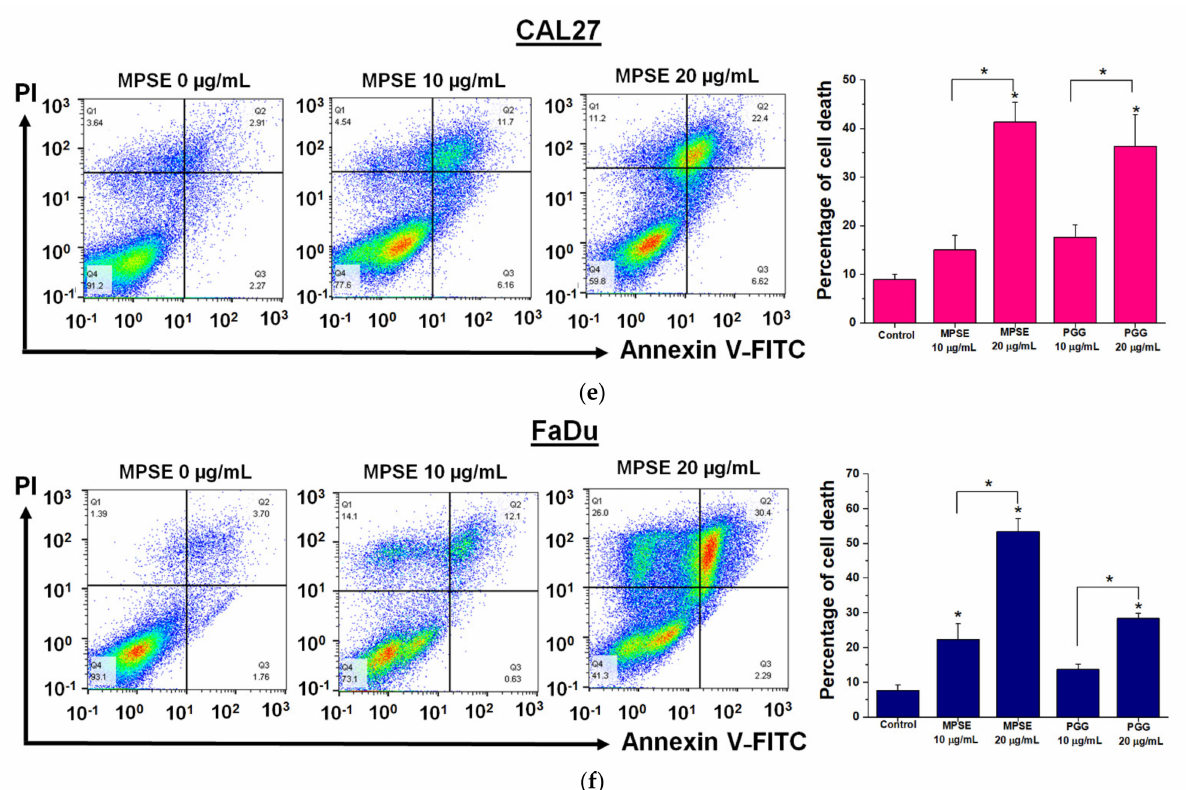
Figure 2. MPSE or PGG suppressed cell proliferation and induced apoptotic cell death in HNSCC cell lines. ( a ) Effect of MPSE or PGG on cell viability of CAL27 cells assessed via MTT assay. ( b ) Effect of MPSE and PGG on cell viability of FaDu cells assessed via MTT assay. ( c , d ) The colony-formation ability of HNSCC cell lines treated with different concentrations of MPSE for 48 h, then seeded (1 × 10 4 ) in triplicate in a 6-well plate. After two weeks of incubation, formed colonies were counted. The graphs represent the mean ± SD ( n = 3) of the number of colonies and a representative image of the colony-formation assay (inset panels). ( e , f ) Apoptosis induction was analyzed using Annexin V/PI staining after 48 h of treatment with either MPSE or PGG at the indicated concentrations. Left: the representative flow cytometry plots are presented for each cell. Right: quantitated total cell death after treatment with different doses of either MPSE or PGG. All data are presented as mean ± SD ( n = 3). Statistical significance was evaluated by one-way ANOVA, followed by post hoc Tukey’s multiple comparison test. * p < 0.05. MPSE, Maprang seed extract. PGG, pentagalloyl glucose. HNSCC, head and neck squamous cell